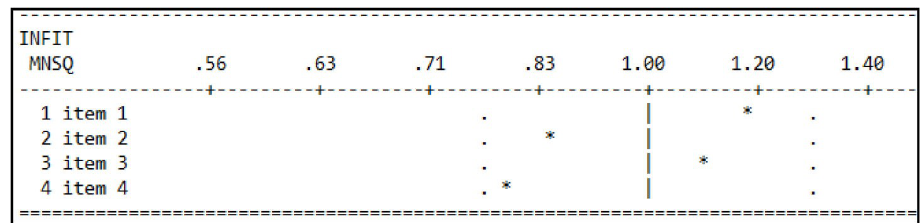
Figure 3. Result of analysis of item fitness of critical thinking ability test